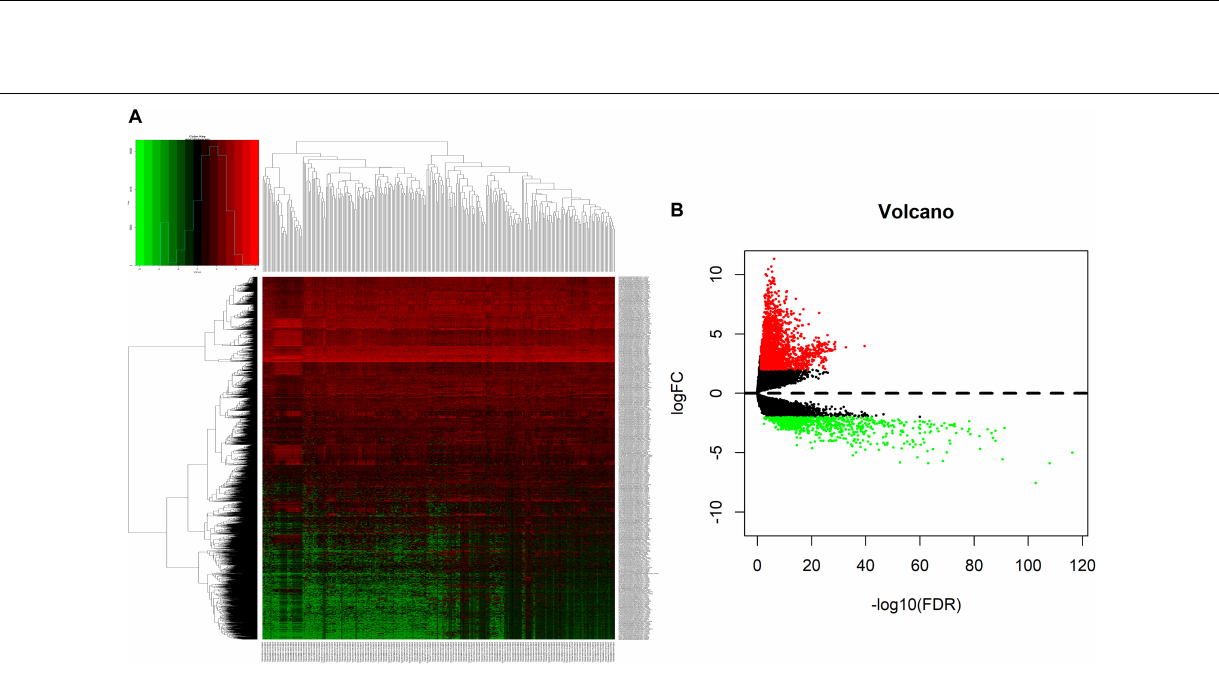
Frontiers in Oncology | www.frontiersin.org